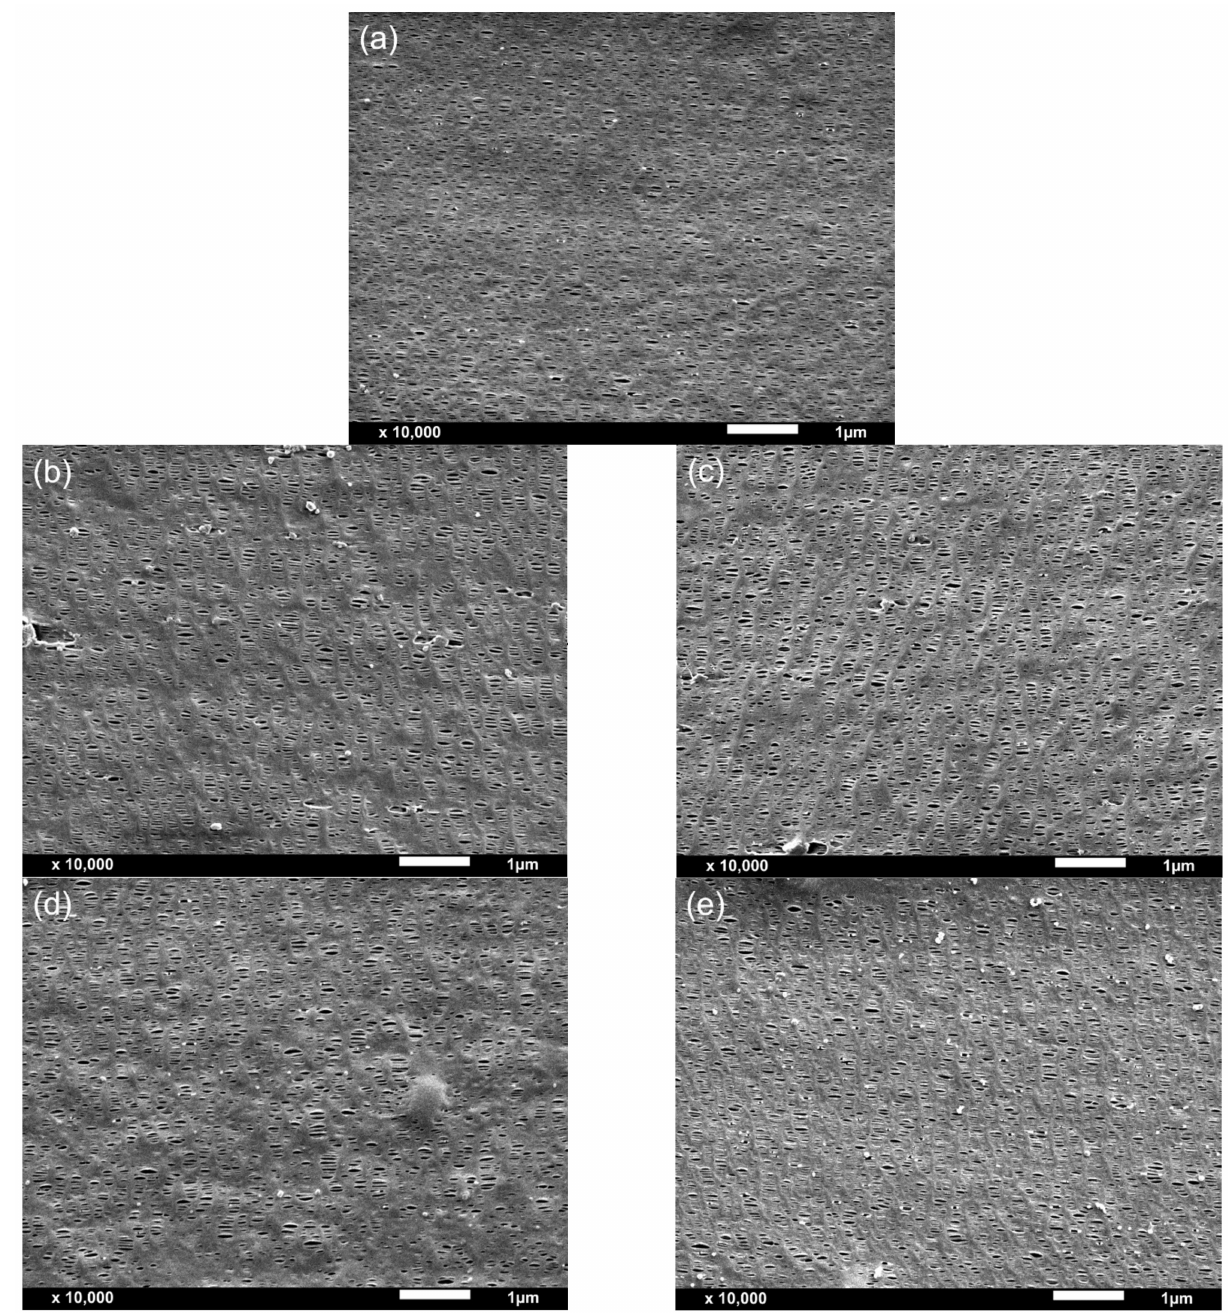
Figure 4. Representative SEM micrographs of the outer layer surfaces of the trilayer membranes. ( a ) Neat polypropylene (PP), ( b ) polypropylene filled with 5 wt% CaCO 3 (PP-5C), ( c ) polypropylene filled with 10 wt% CaCO 3 (PP-10C), ( d ) polypropylene filled with 5 wt% talc (PP-5T), ( e ) polypropylene filled with 10 wt% talc